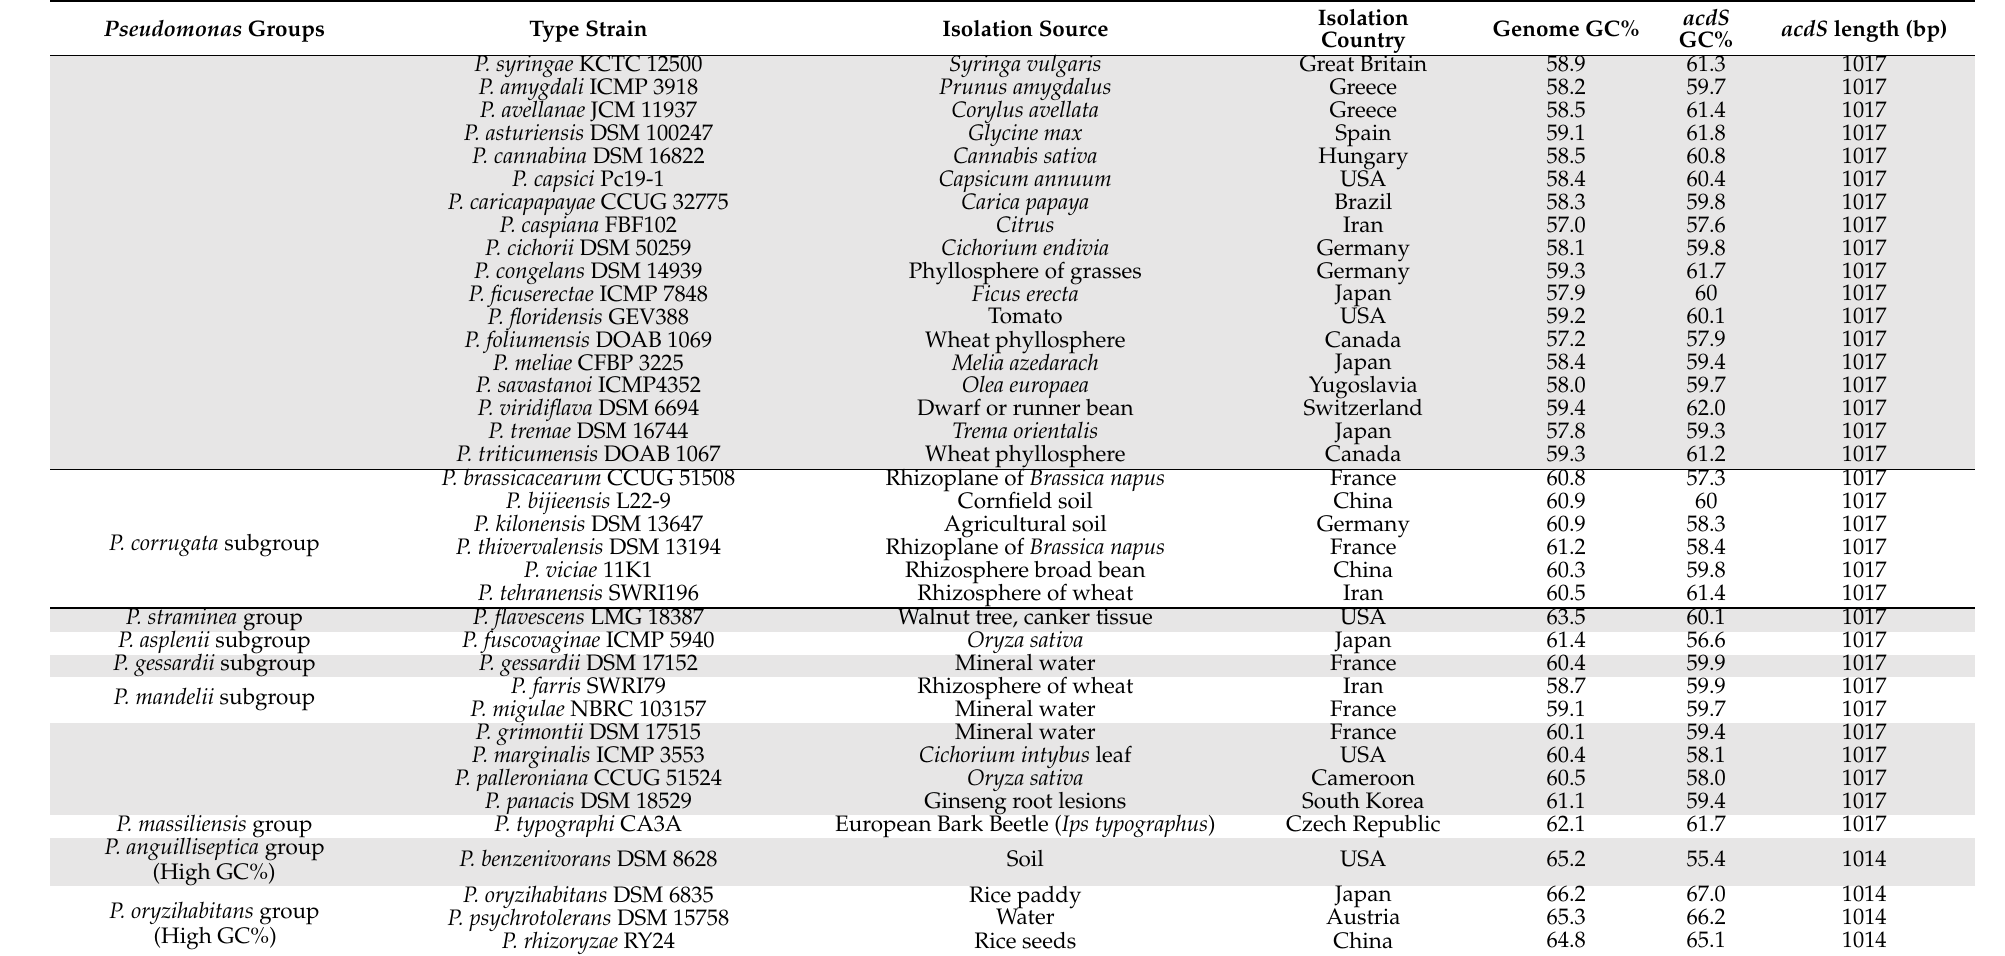
Table 1. Properties of ACC deaminase-containing Pseudomonas type